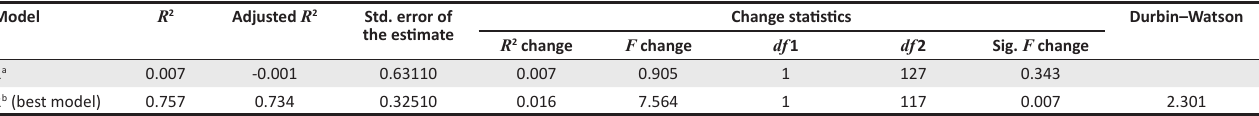
TABLE 4: Model summary results. Model